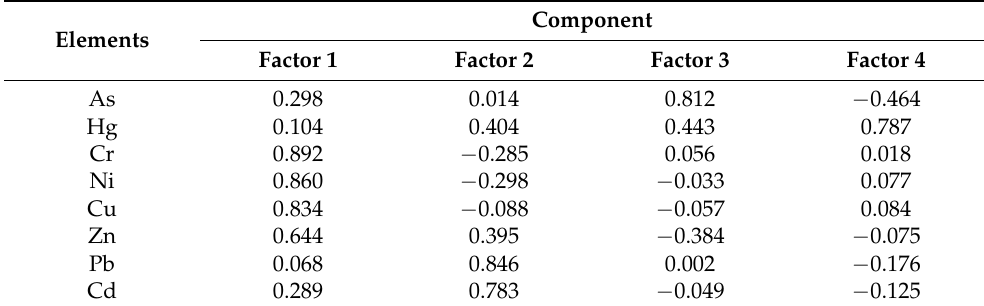
Table 2. Varimax rotated matrix for the parameters in the first four principal components obtained via APCS analysis. Component Elements Factor 1 Factor 2 Factor 3 Factor 4 As 0.298 0.014 0.812 − 0.464 Hg 0.104 0.404 0.443 0.787 Cr 0.892 − 0.285 0.056 0.018 Ni 0.860 − 0.298 − 0.033 0.077 Cu 0.834 − 0.088 − 0.057 0.084 Zn 0.644 0.395 − 0.384 − 0.075 Pb 0.068 0.846 0.002 − 0.176 Cd 0.289 0.783 − 0.049 −